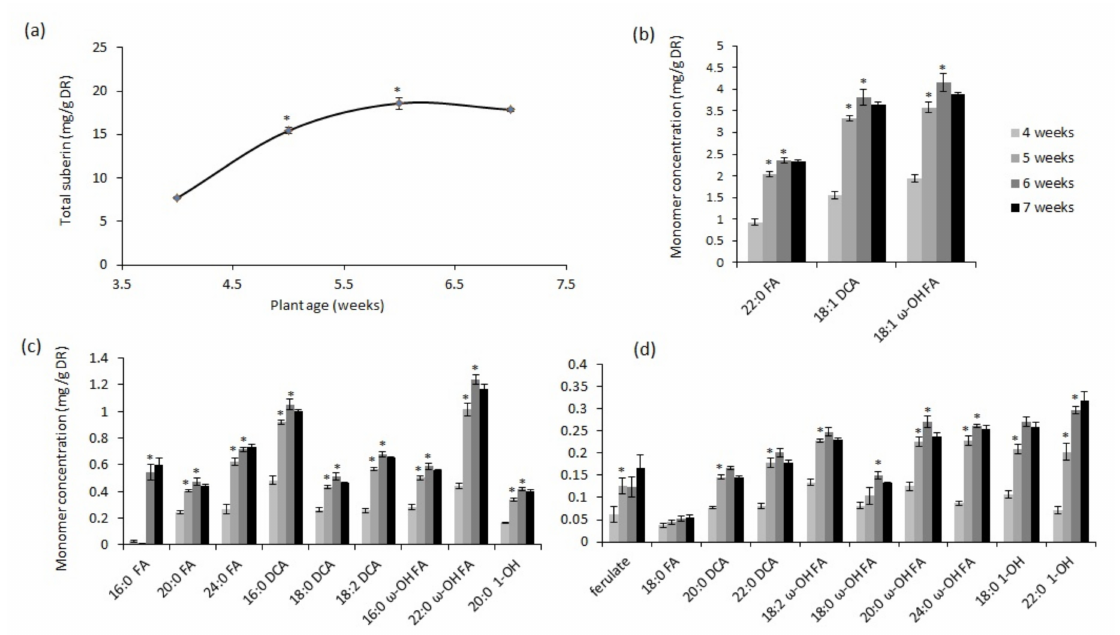
Figure 1. Time-course analysis of Arabidopsis root suberin through weeks 4 to 7 of development. ( a ) Total poly-aliphatic suberin content, ( b ) most-abundant suberin monomers, ( c ) moderately abundant suberin monomers, and ( d ) least-abundant suberin monomers in roots of wild-type (Col-0) plants at different ages (4–7 weeks) grown under a constant, non-drought condition (20% water level). Data points are mean values in milligrams per gram of delipidated dry residue (DR) from five replicate samples ± SE. Each replicate represented a pool of roots from 4–5 plants. FA, fatty acid; DCA, dicarboxylic acid; ω -OH FA, omega hydroxy fatty acid; 1-OH, primary alcohol. Asterisks indicate significance at p < 0.05 by Student’s t -test compared to the suberin content of the previous